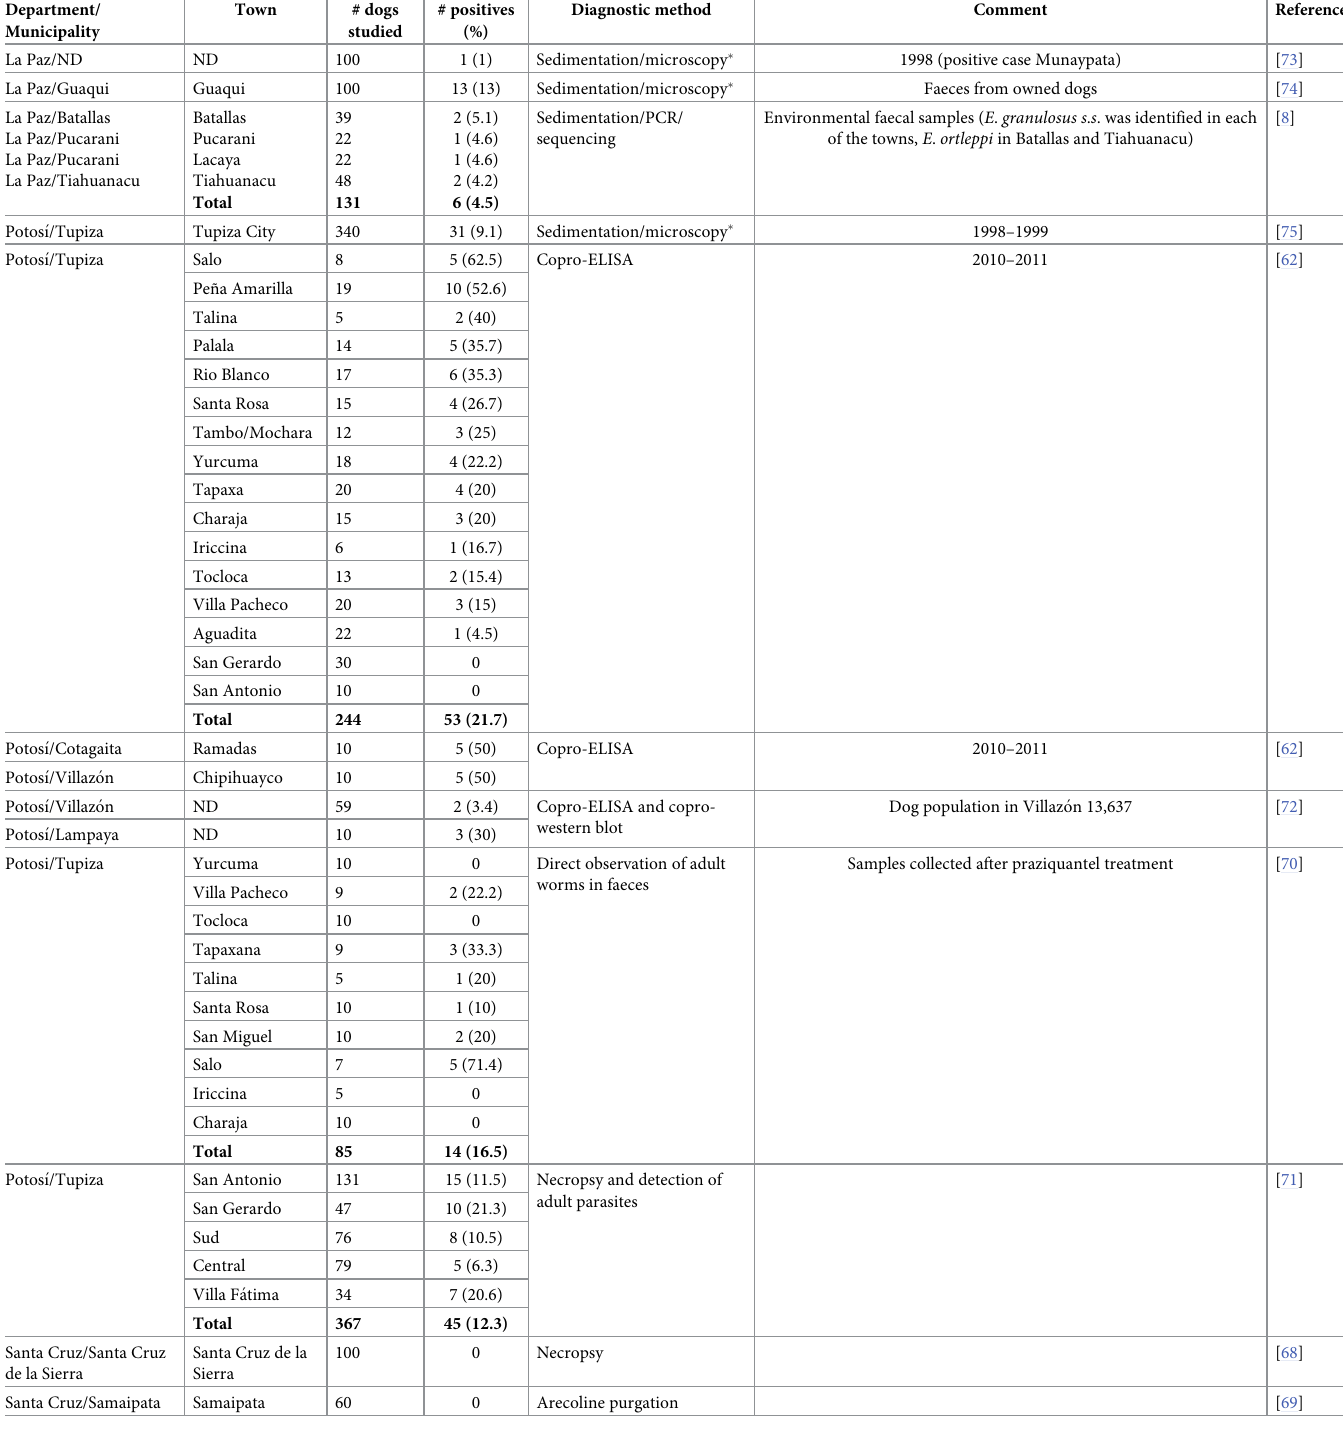
Table 3. Summary of reports of canine echinococcosis and taeniid infection in Bolivia by departments, municipalities, and towns. Department/